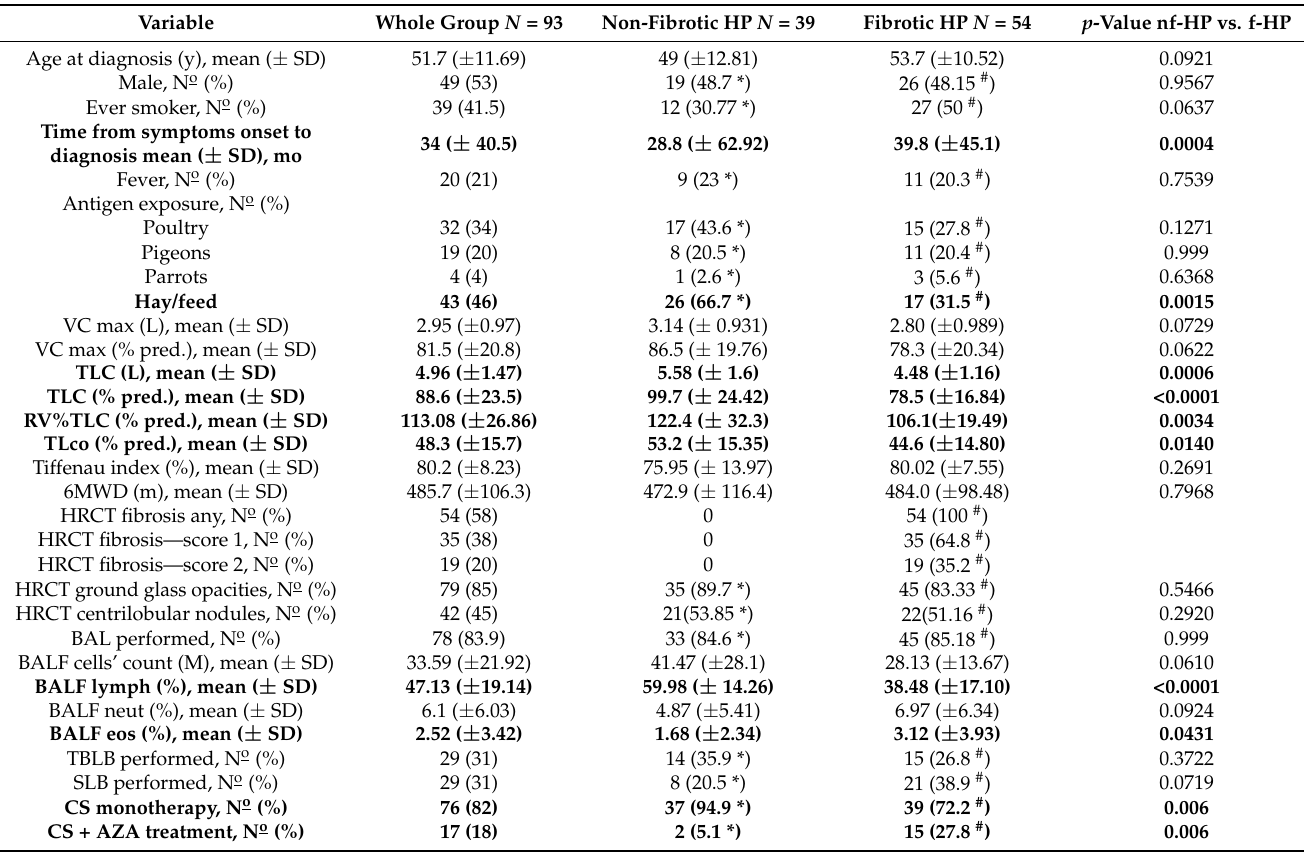
Table 2. Patients’ baseline